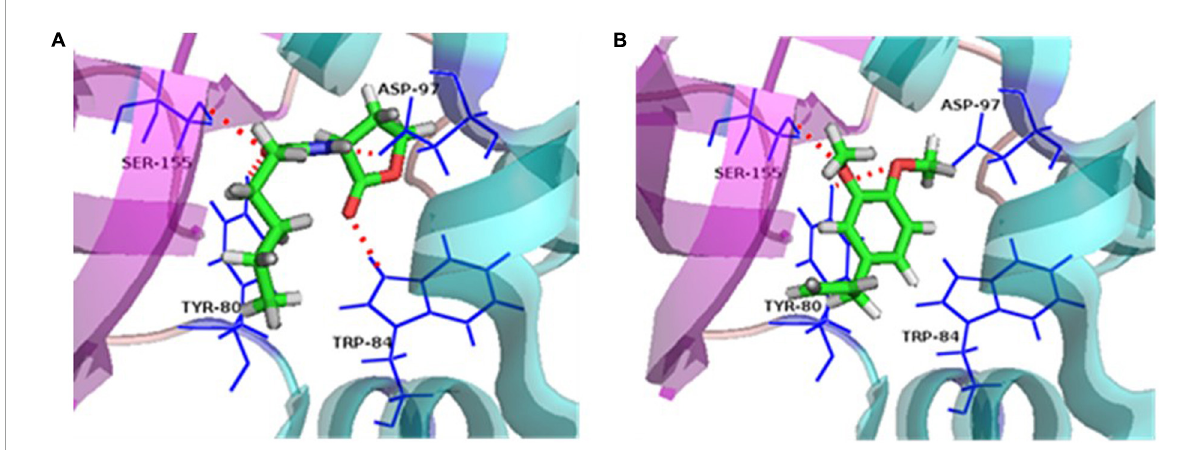
FIGURE7 Ligand-protein interaction. (A) Docking of C6-HSL and CviR protein. (B) Docking of methyleugenol (ME) and CviR protein. Target structures were shown as ribbon diagram. The ligand structures are colored in green, red, and gray. Red dashed lines represent the hydrogen bonds.